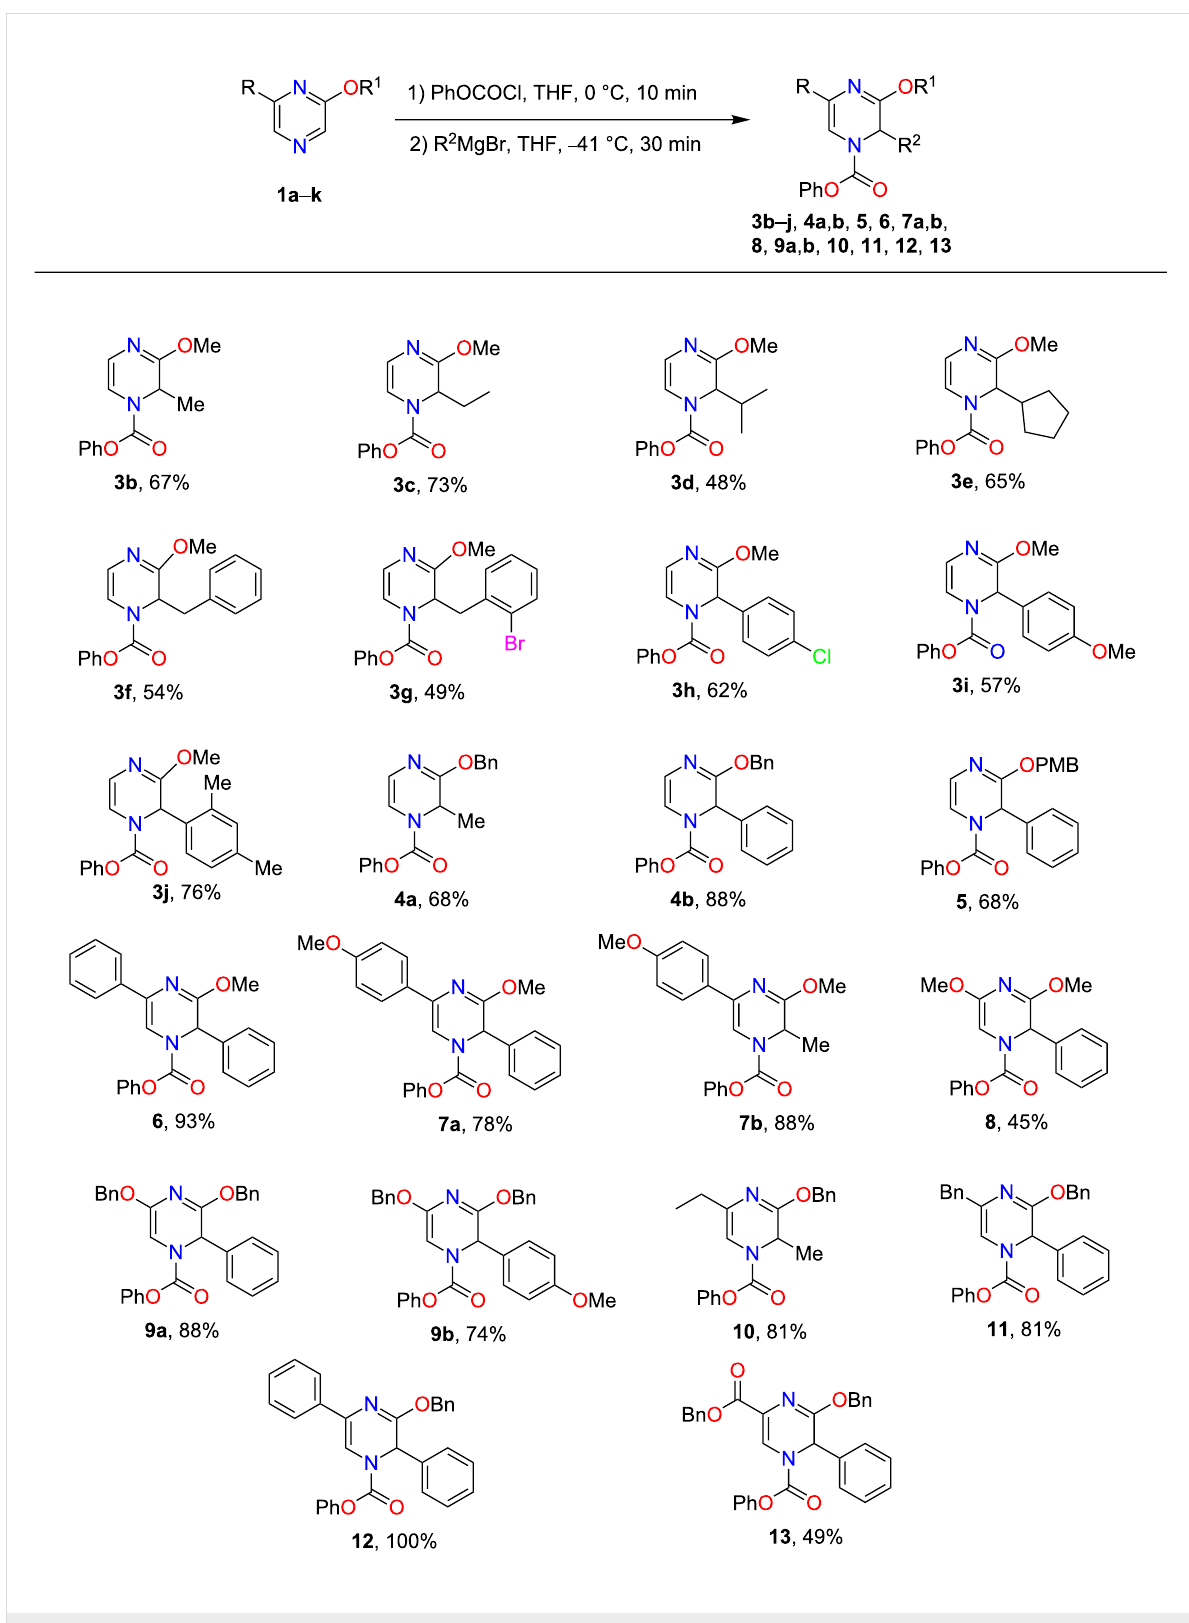
Figure 1: Regioselective addition of Grignard reagents to mono- and disubstituted pyrazinium salts (yields refer to isolated